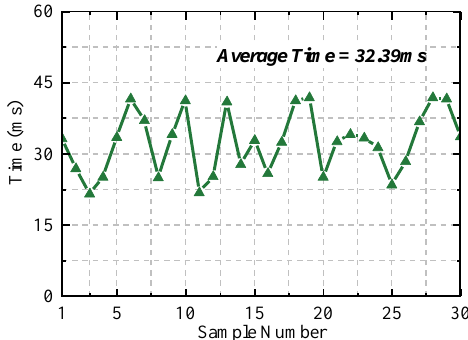
Figure 16. Fault tolerance times of thirty samples.